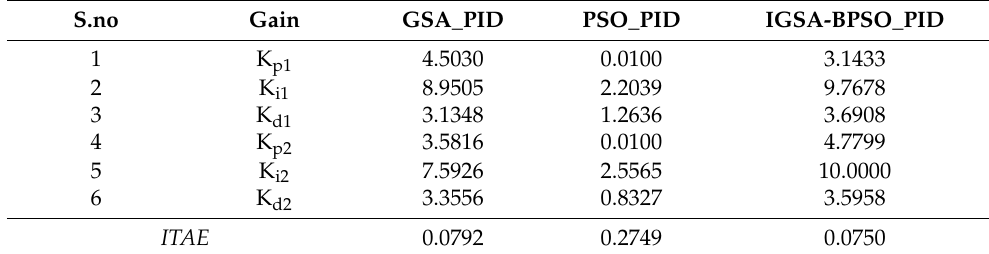
Table 7. PID parameters tuning for hybrid test system and ITAE values: CVT.